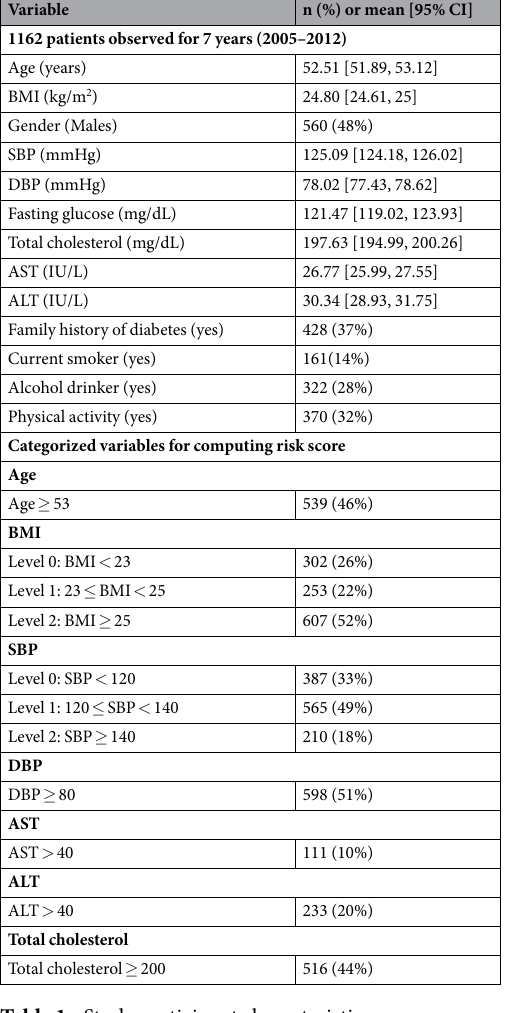
Table 1. Study participant